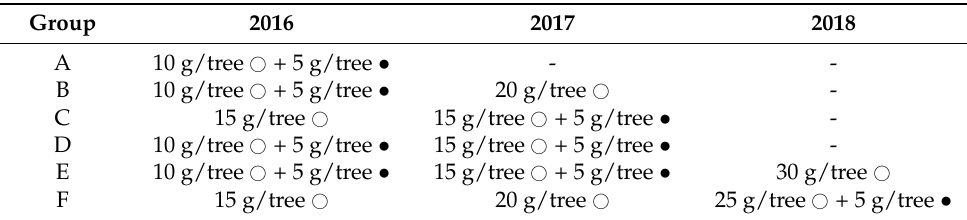
Table 1. The timing and rate of fertilization of pear trees divided according to their groups. Group